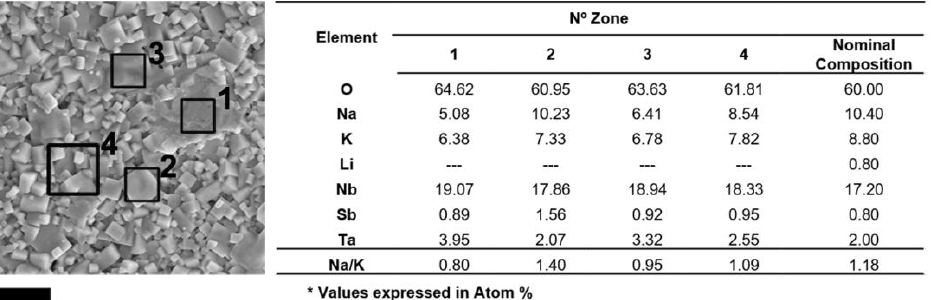
Figure 4. EDS analysis on different points in the KNL − (N0.9 − xTSx)ceramics with x = 0.04. Scale bar, 10 µ m. The table at the right presents the composition on the regions shown on a micrograph derived from EDS spectra. The table represents the atomic percentages of elements From the EDX analysis, the average compositions for the different points marked in Figure 4 could be calculated, obtaining compositions at points 1 and 3 (glassy phase), and at points 2 and 4 (main grains) of (K0.33Na0.29Li0.04)(Nb0.78Ta0.18Sb0.04)O3 and (K0.37Na0.40Li0.04)(Nb0.85Ta0.11Sb0.04)O3,